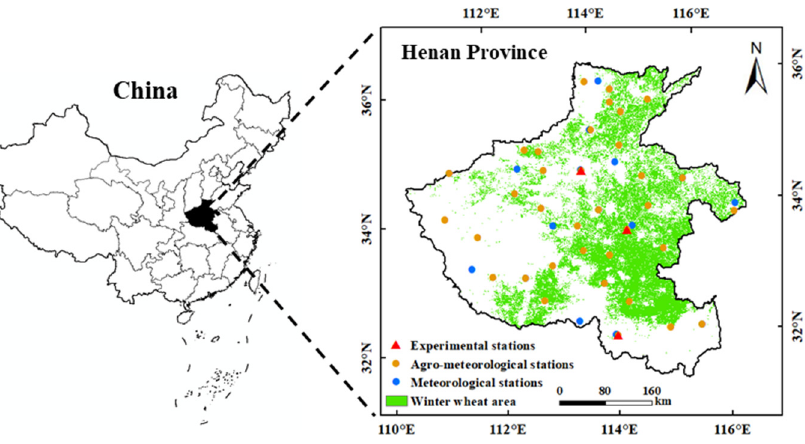
Figure 1. Locations of the study area and the agro-meteorological stations in Henan Province, China.